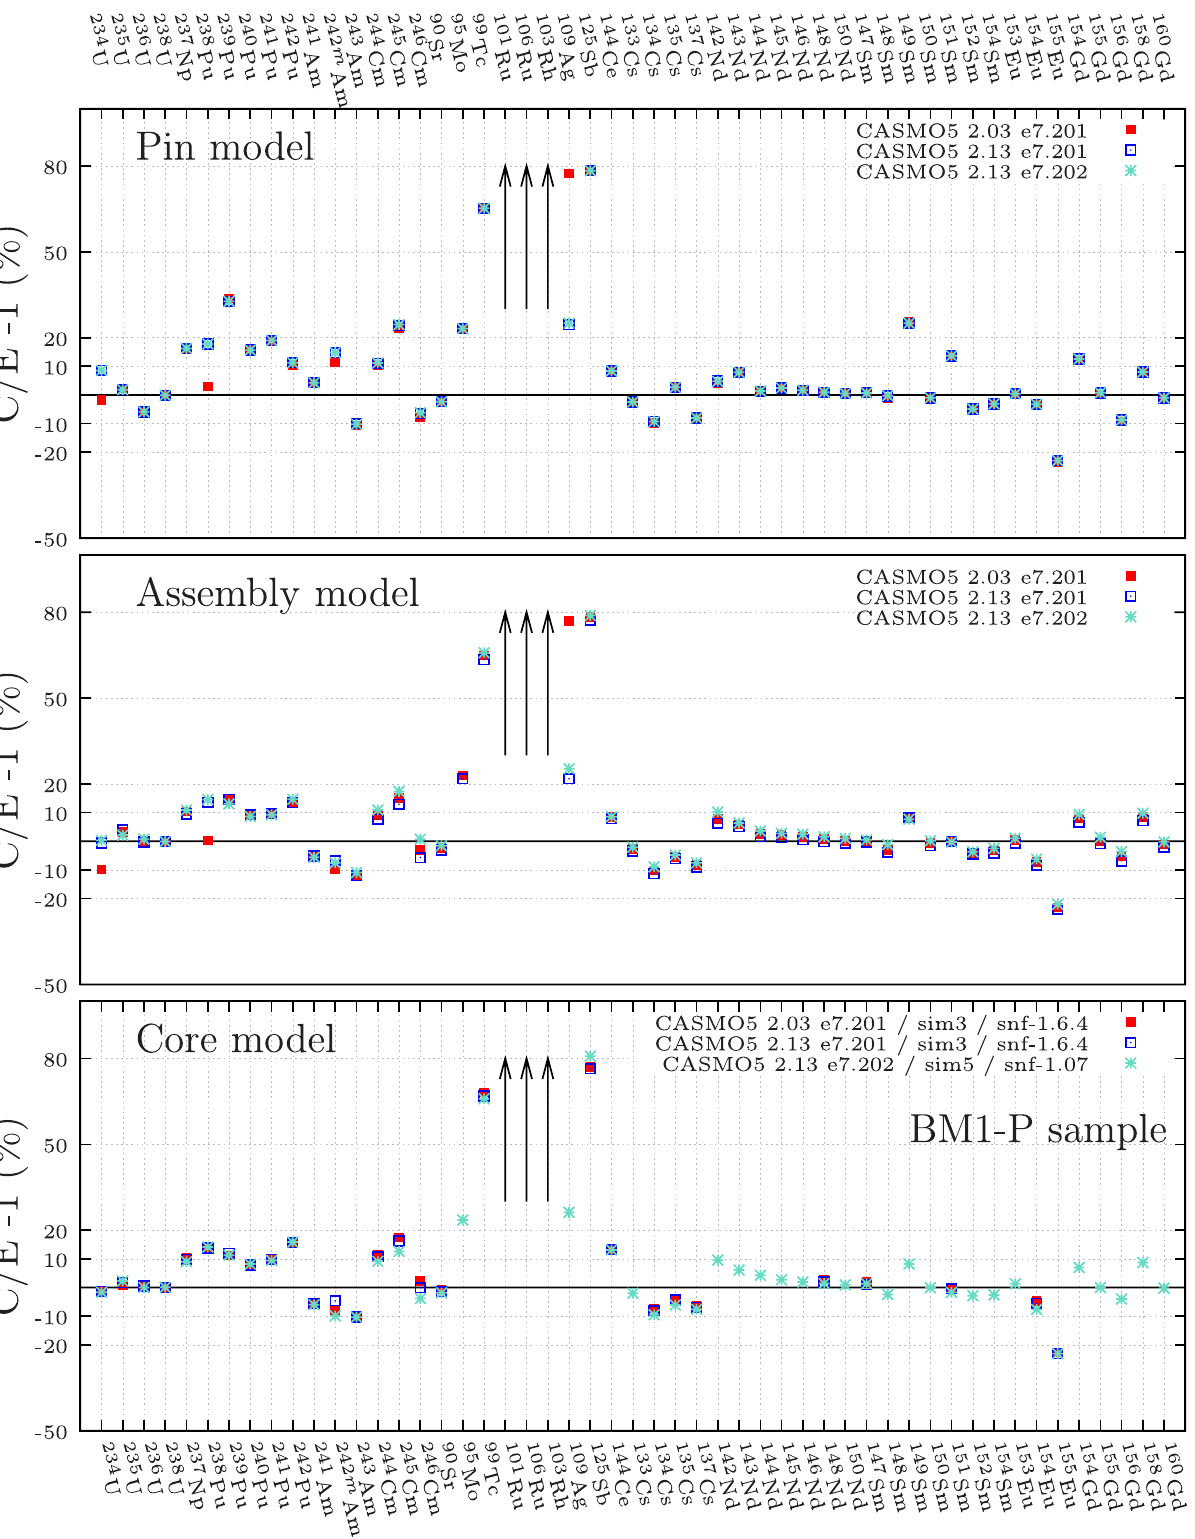
Fig. 4. Comparisons between calculated and measured values (C/E–1) for each measured isotopes from different calculations for the BM1-P measurements (PSI); top and middle: CASMO5 2D calculations only, bottom: 3D-1 case. Vertical arrows indicate out-of-scale